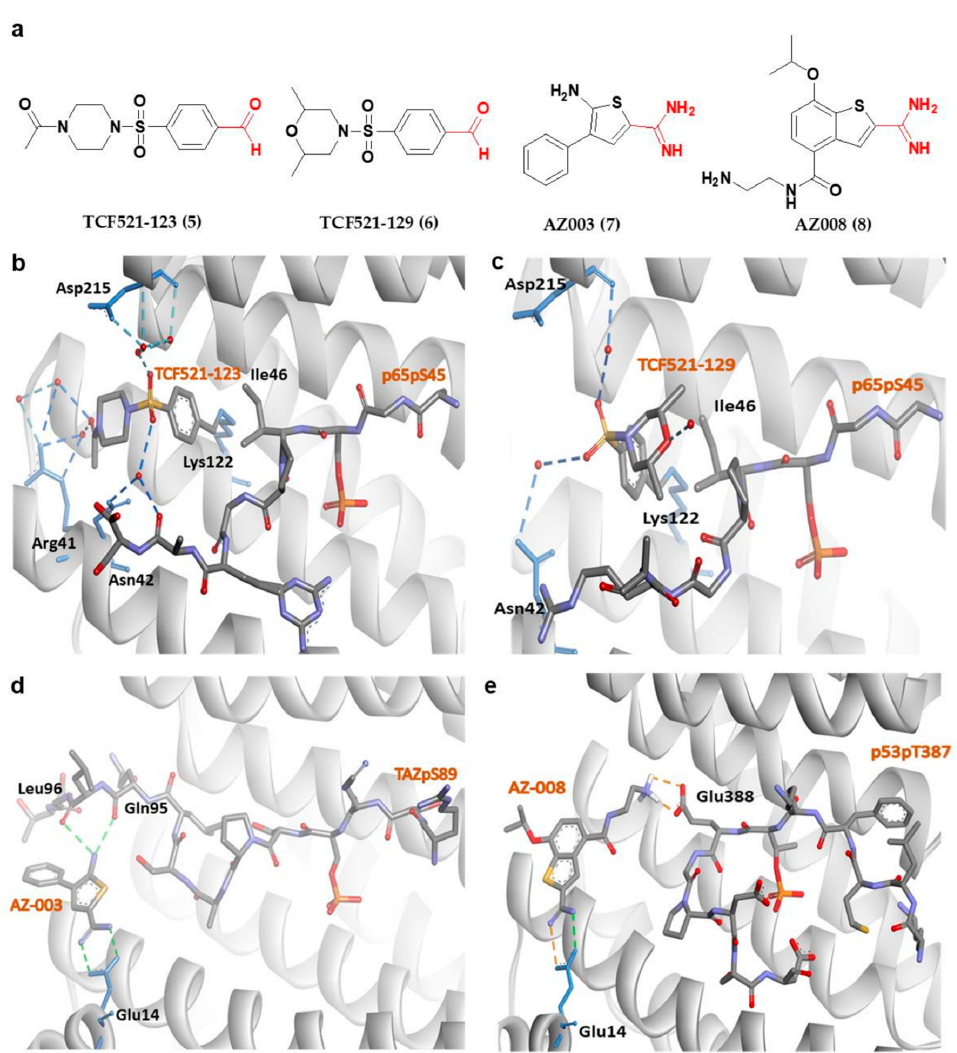
Figure 5. ( a ) Chemical structure of fragment-derived small molecule stabilizers of 14-3-3 σ PPI with the key functional groups (i.e., aldehyde and amidine groups) colored in red. ( b ) 14-3-3 σ / P65 / TCF521-123 ternary complex (PDB: 6YPY). ( c ) 14-3-3 σ / P65 / TCF521-129 ternary complex (PDB: 6YQ2). ( d ) 14-3-3 σ / TAZ / AZ-003 ternary complex (PDB: 6RHC). ( e ) Docked structure of AZ-008 / 14-3-3 σ in complex with p53pT387. Water-mediated hydrogen bonds are shown as blue dashes, while hydrogen bond and ionic interactions are shown as green and orange dashed lines,